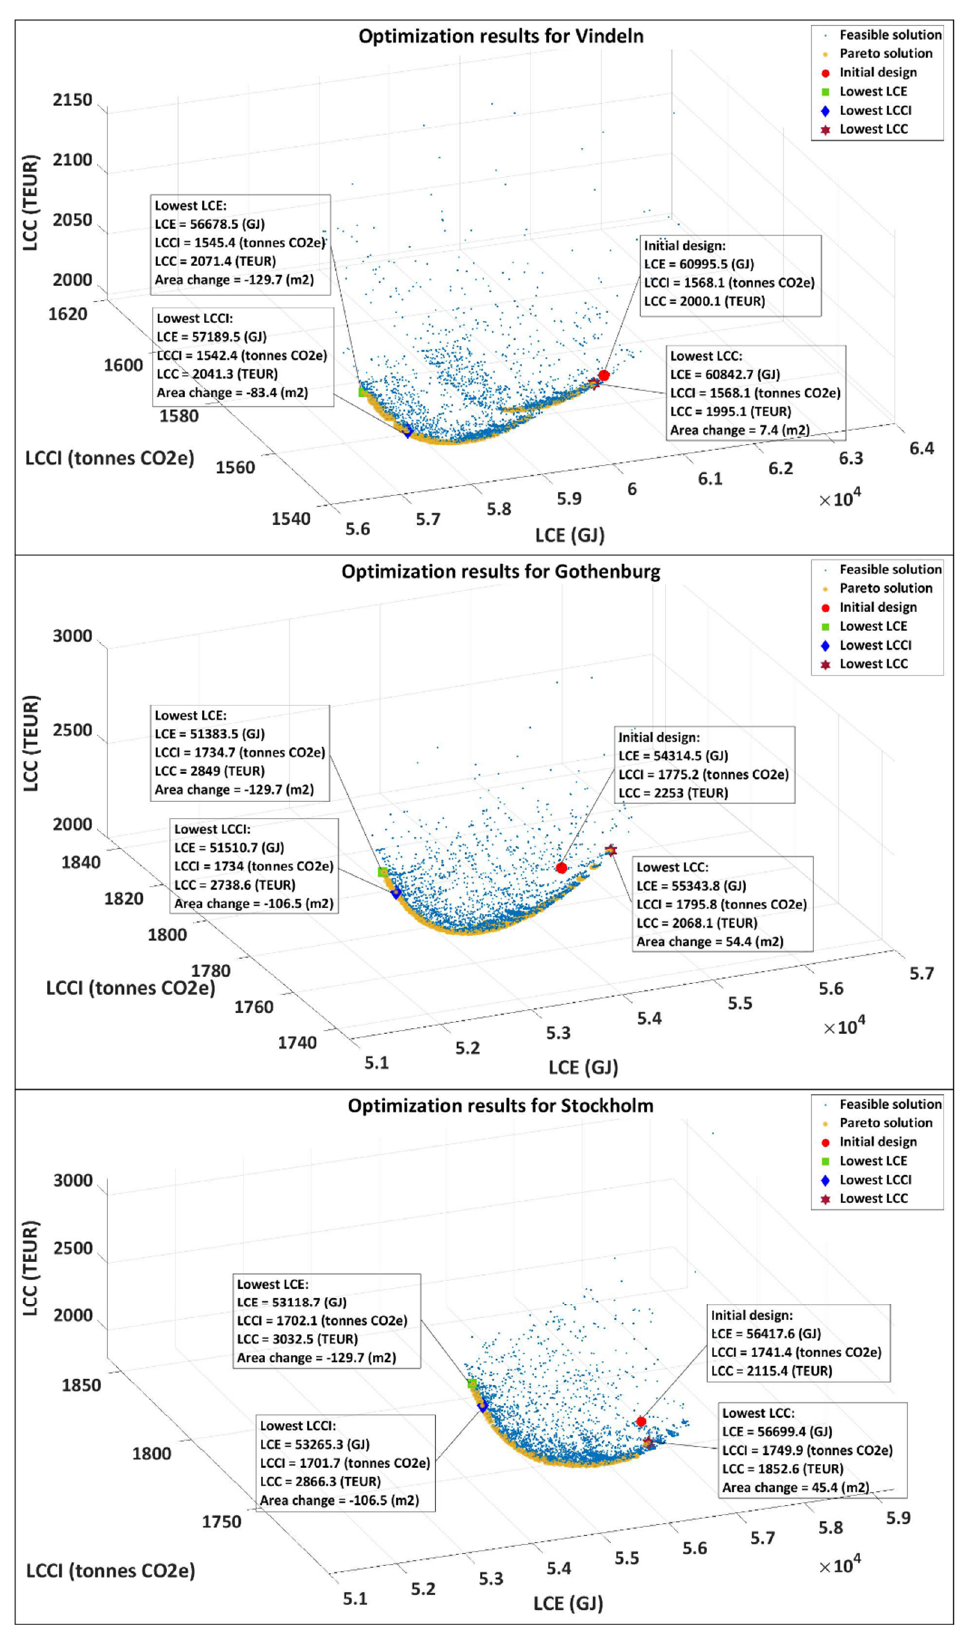
Figure 5 . The life cycle energy, carbon impact, and cost values of feasible solutions obtained from the multi-objective optimization for the building concept in Vindeln, Gothenburg, and Stockholm. A colour print is recommended.